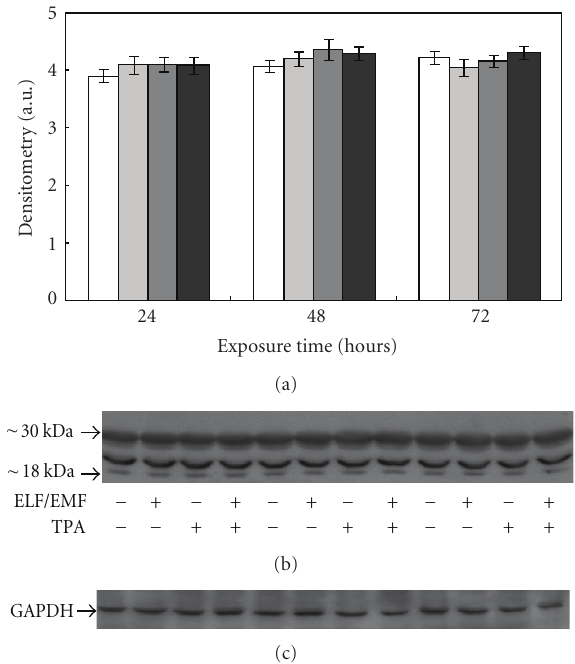
Figure 7: E ff ect of ELF-EMFs exposure and TPA treatment on 20S proteasome levels. Representative autoradiography of 20S proteasome in Caco cells exposed to ELF-EMFs. The densitometric analysis from six separate blots provided for quantitative analysis of the amount of 20S “core” is presented (a) and a representative Western blot is shown in (b). Equal protein loading was verified by using an anti-GAPDH antibody (c). The immunostaining was per- formed using an anti-20S proteasome antibody, and the detection was executed by the Enhanced Chemiluminescence Western blot analysis system.